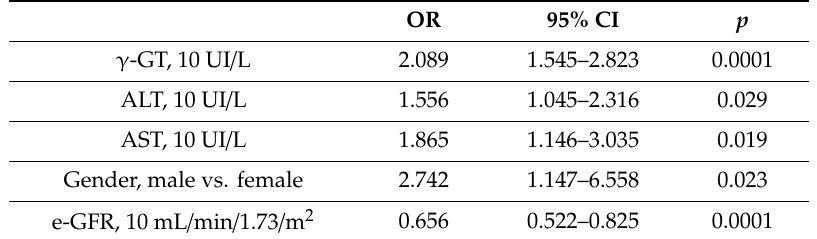
Table 5. Multiple logistic analysis of endothelial dysfunction in Subgroup A ( n = 247).